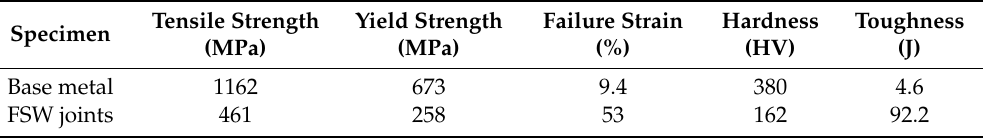
Table 2. Mechanical properties of the base metal and the FSW